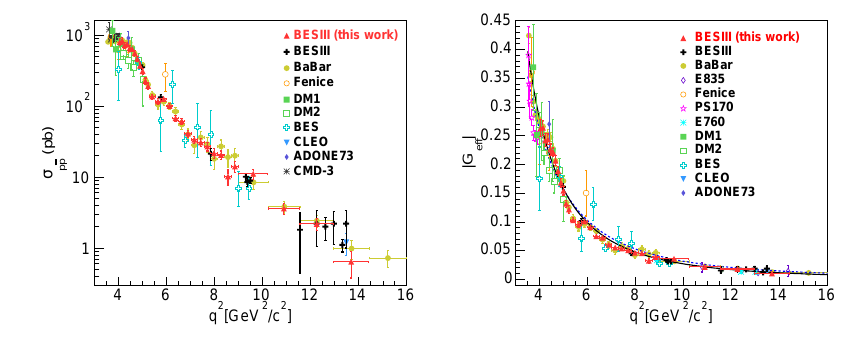
Figure 1. The measured cross sections and form factors via ISR process.